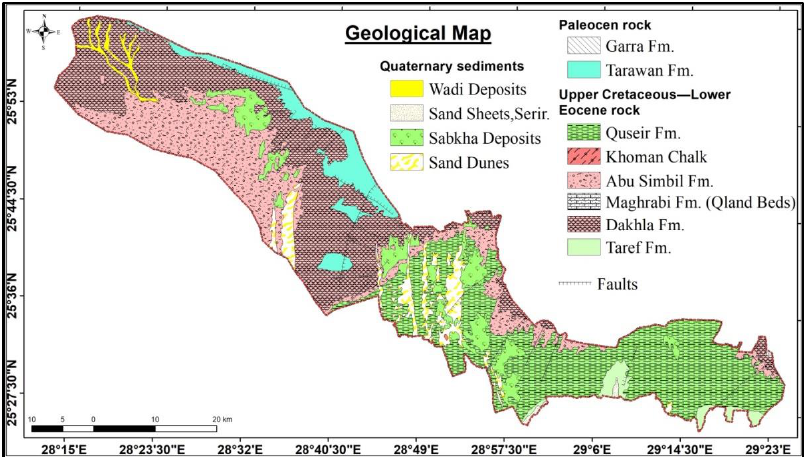
Figure 2. Geological map of the study area (modified by UNESCO, 1997) [56].